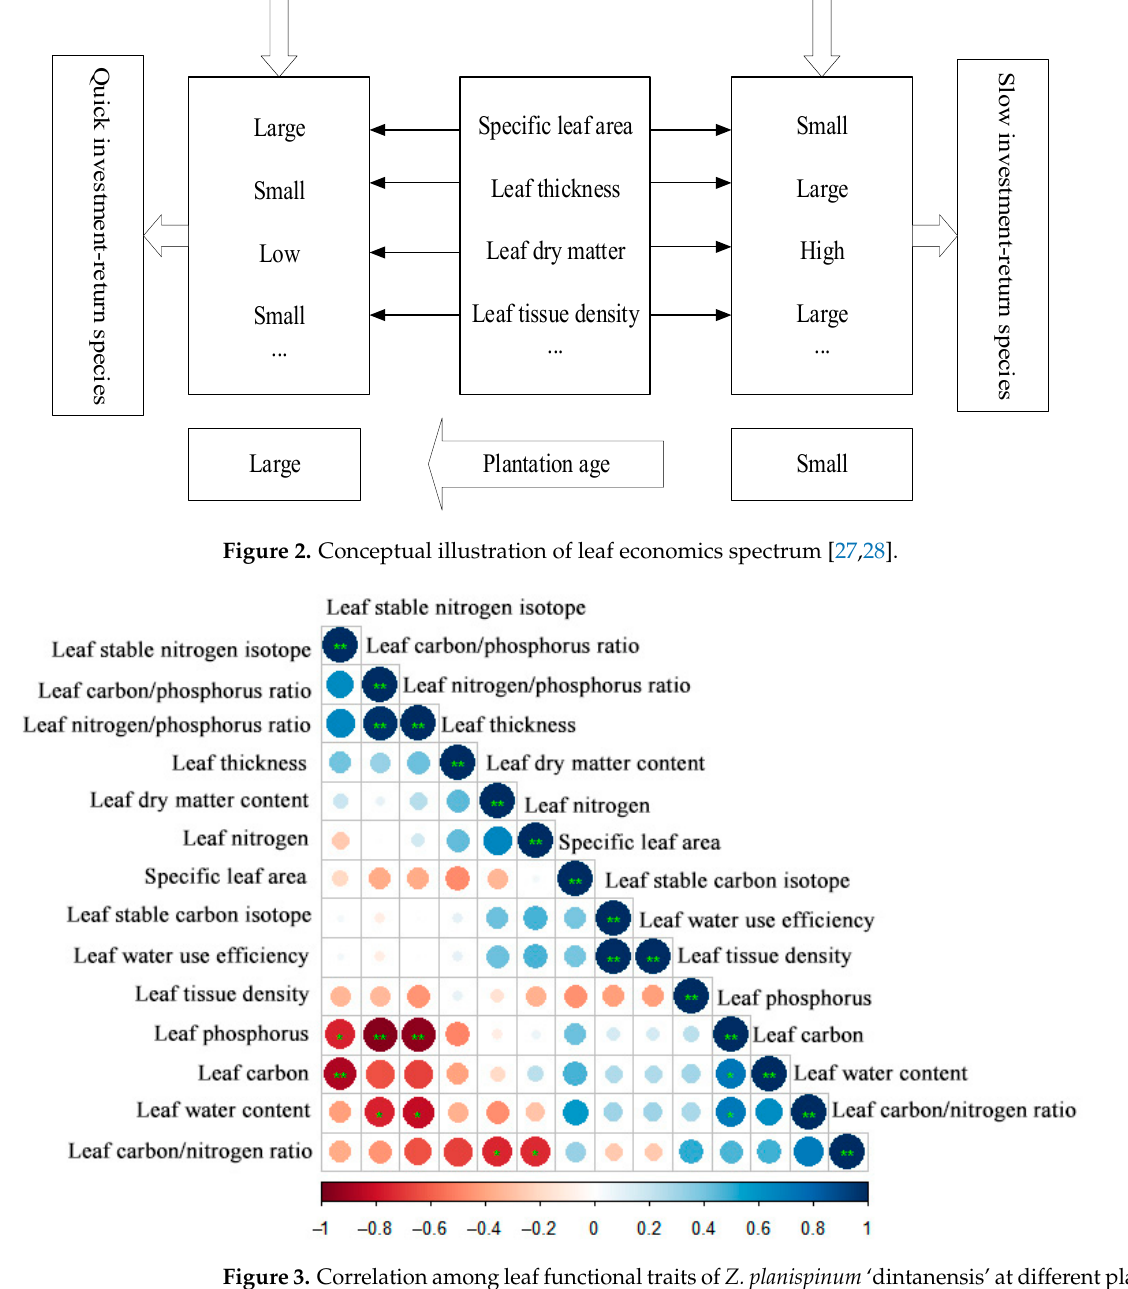
Figure 3. Correlation among leaf functional traits of Z. planispinum ‘dintanensis’ at different plantation ages. Circles with asterisks indicate significant correlations at the 0.05 level (*) and the 0.01 level (**).